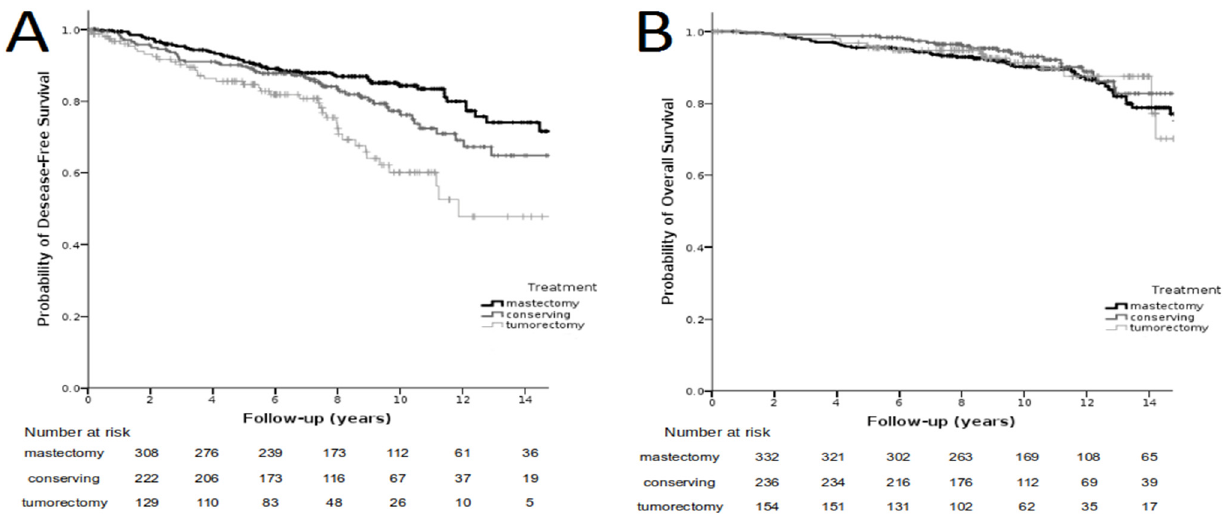
Figure 2. Recurrence-free survival in the group of 737 patients depending on the type of treatment; p < 0.001 (left side, A ). Overall survival in the group of 737 patients depending on the method of p < 0.001 (left side, ( A )). Overall survival in the group of 737 patients depending on the method of treatment; p = 0.329 (right side, B ). “+” indicates censored. treatment; p = 0.329 (right side, ( B